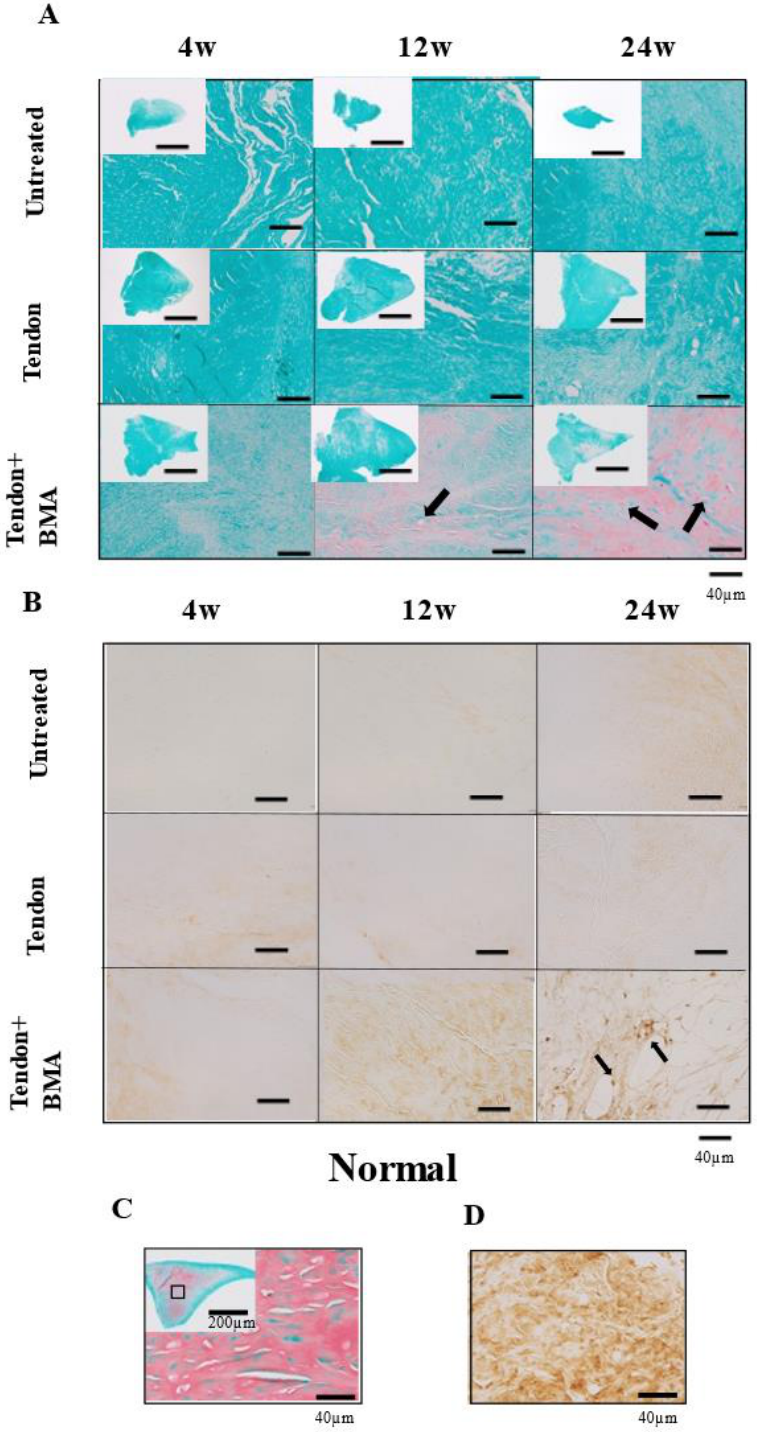
Figure 4. Safranin O staining and type II collagen immunostaining of native and regenerated menisci in the three groups at 4, 12, and 24 weeks postoperatively. ( A ) Safranin O staining. Positive safranin O staining was consistently noted at the central margin of the grafts in the tendon + BMA group at 12 and 24 weeks postoperatively (black arrows). ( B ) Type II collagen immunostaining. Immunohistochemistry exhibited positive staining of type II collagen in the cells at 24 weeks postoperatively (black arrows). ( C , D ) Safranin O staining and type II collagen immunostaining of the native meniscus.